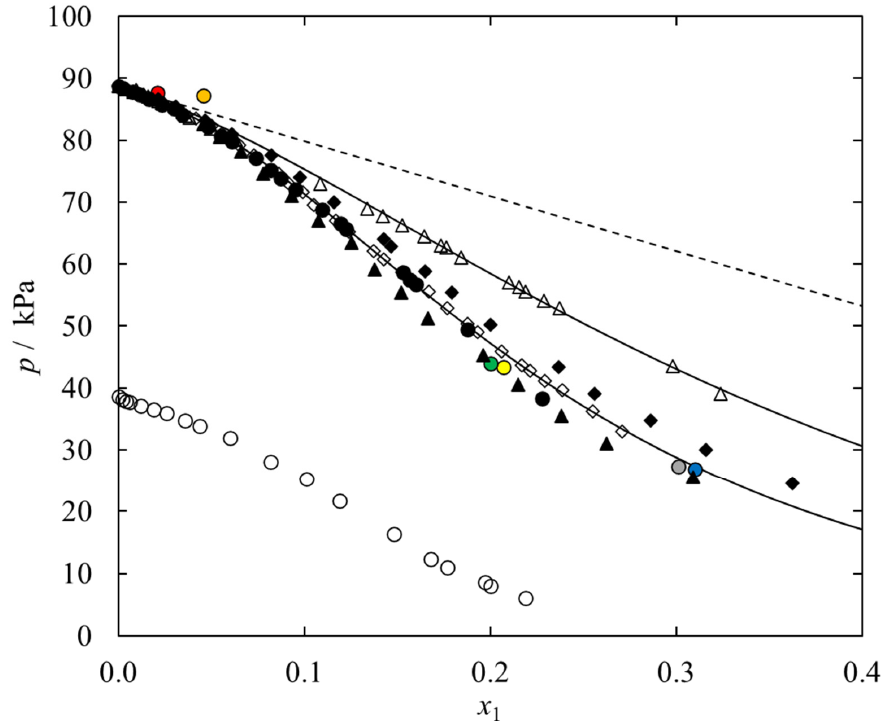
Figure 3. Comparison of the VLE data for the systems {[Cation][DMP] (1) + Ethanol (2)} vs. ionic liquid mole fraction, x 1 , at temperature T = 348.15 K; ♦ , [C 1 C 2 MOR][DMP] (this work); ● ,